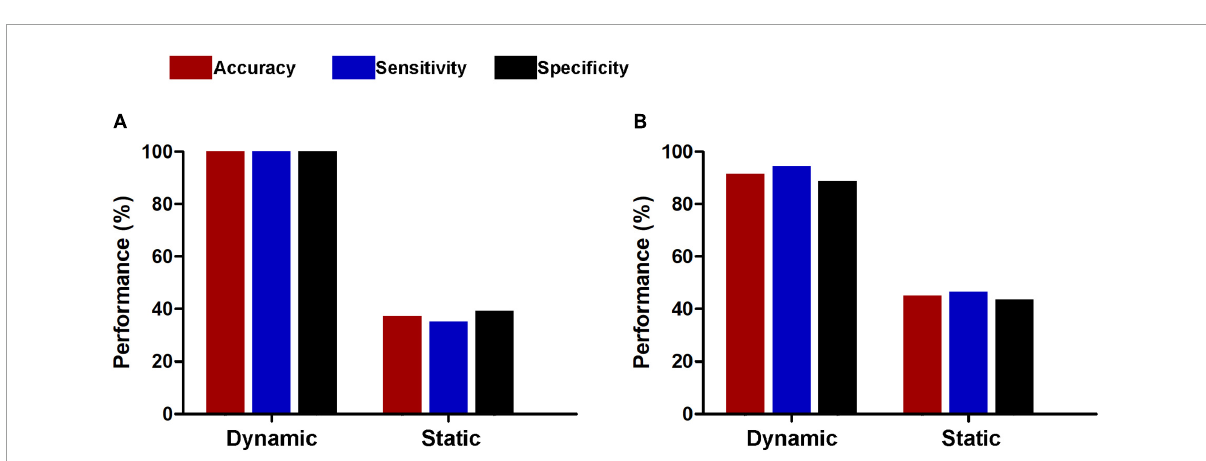
FIGURE6 Classification performances of dynamic and static functional connectivity-based classifiers using subsets of connections selected by thresholds of P < 0.05 (A) and 0.001 (B)